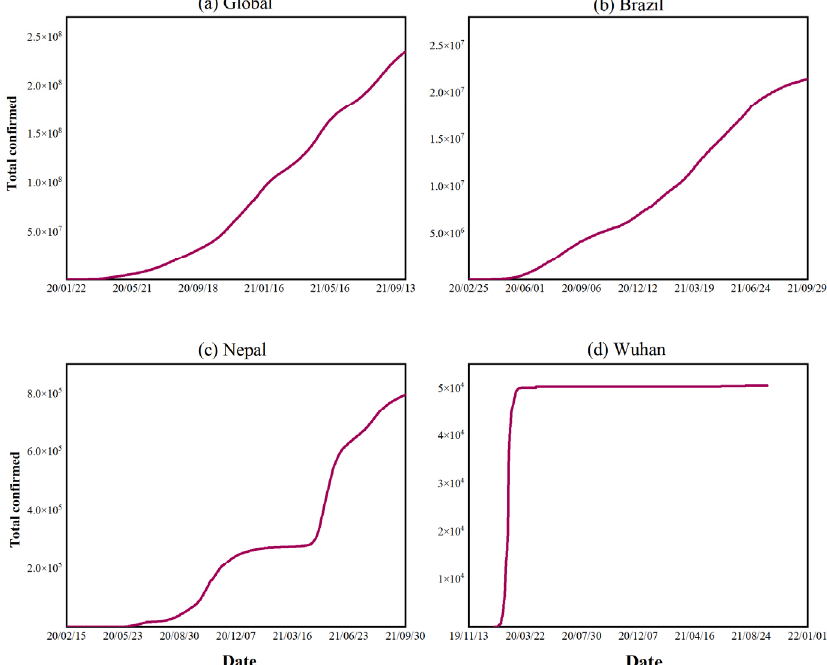
Figure 1. Global and typical national and regional epidemic trends. Figures ( a – d ) represent the cumulative confirmed cases of the COVID-19 globally, in Brazil, Nepal, and Wuhan, respectively. Table 1. Time windows for the different countries and regions